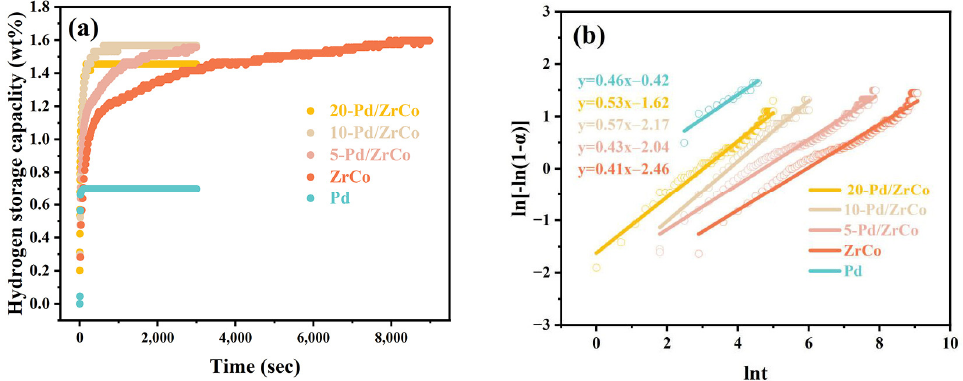
Figure 3. ( a ) The initial hydrogen absorption kinetic curves of the Pd, ZrCo, and Pd/ZrCo films under 0.5 MPa of H 2 at room temperature; ( b ) plots of ln [ − ln ( 1 − α )] vs. ln t for the hydrogen absorption kinetic curves.